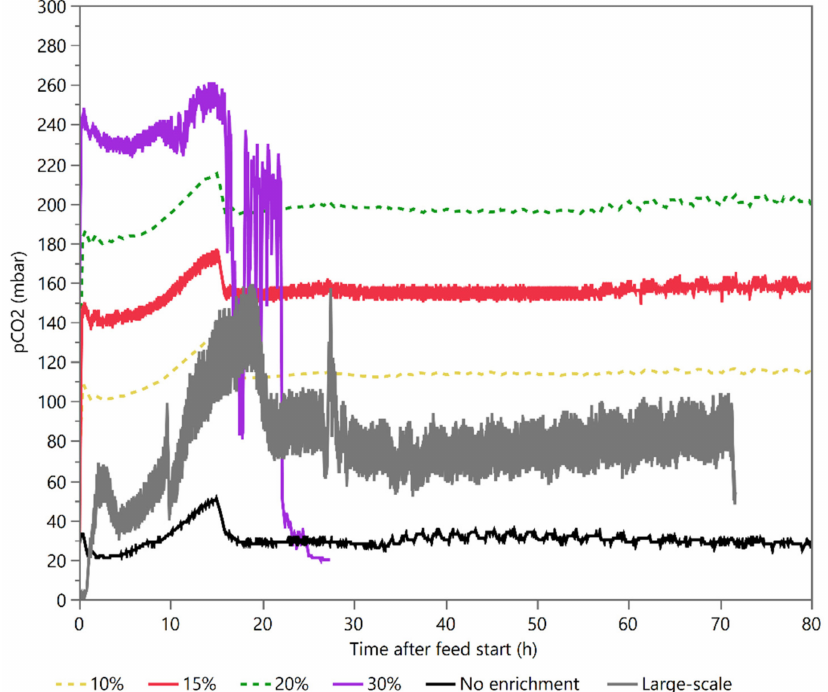
Figure 3. Measured and estimated pCO 2 concentrations. pCO 2 concentrations were measured from fermentations with 15% CO 2 enrichment (red), 30% CO 2 enrichment (purple), non-enriched control fermentations (black), and a large-scale fermentation (grey). pCO 2 values from 10% (yellow dashed line) and 20% (green dashed line) enrichments were not measured but estimated from the measurements from the 15% and the control fermentations. The estimated pCO 2 curves are shown as 20 min moving averages of measured pCO 2 data with superimposed values from the inlet air stream to reflect the actual